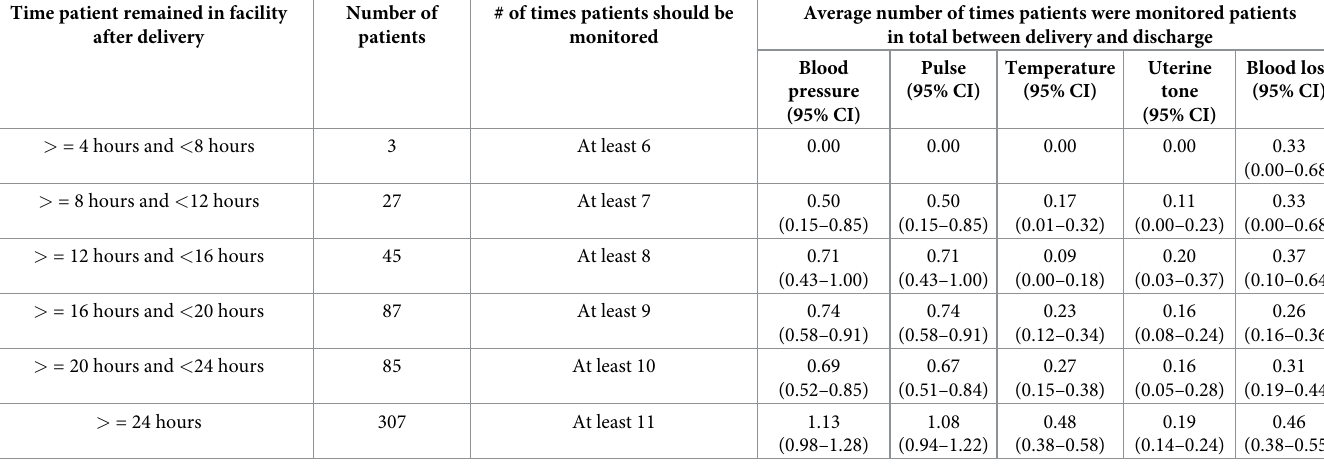
Table 3. Total times patients were monitored, by amount of time remaining in facility